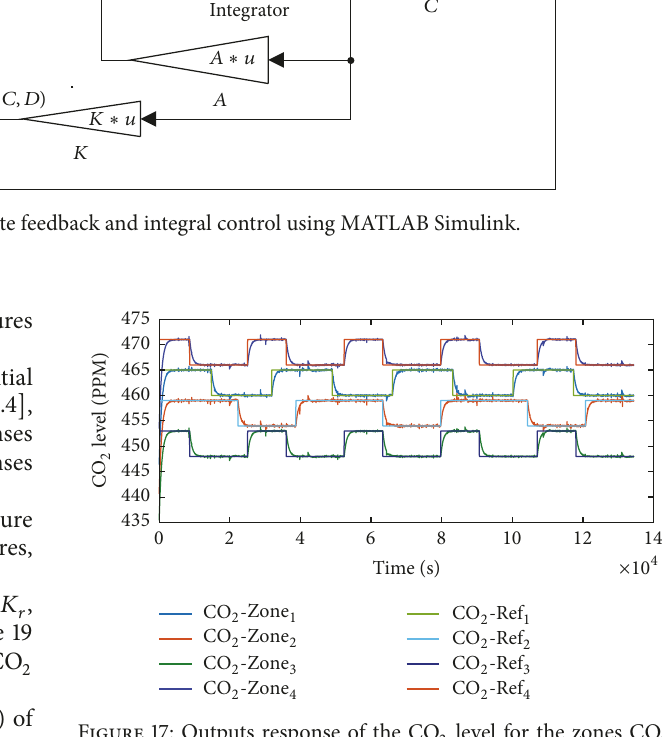
good approximation results in which hot water consumption and electricity consumption are compared with actual